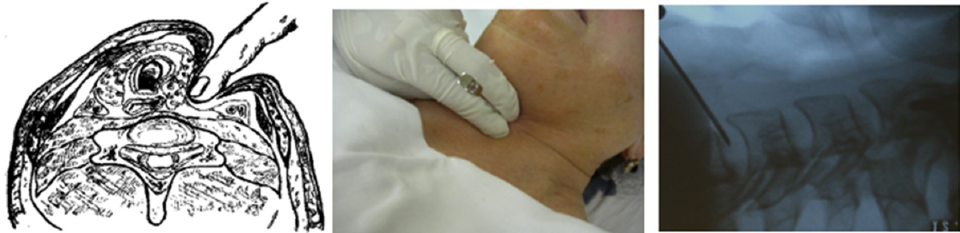
Figure 6. LRD of the cervical spine according to the Cloward approach.